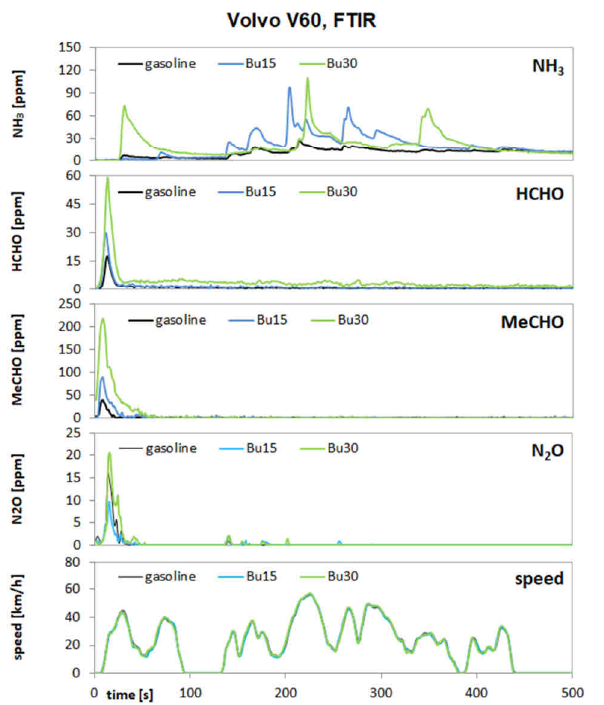
Fig. 11. Comparison of NH 3 -, HCHO-, MeCHO- & N 2 O-emissions in the first part of WLTC cold with different fuels